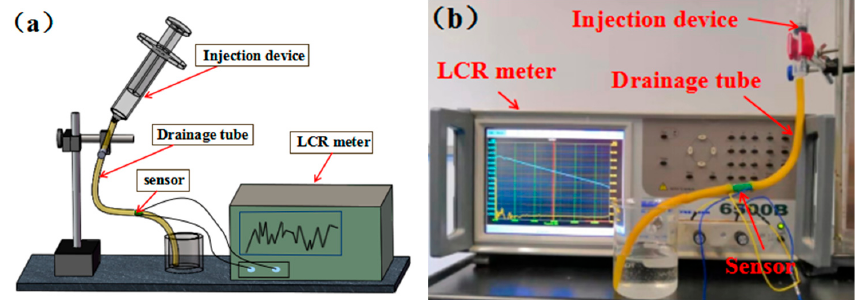
Figure 5. ( a ) Schematic diagram of the simulation experiment system. ( b ) Photo of the simulation experiment